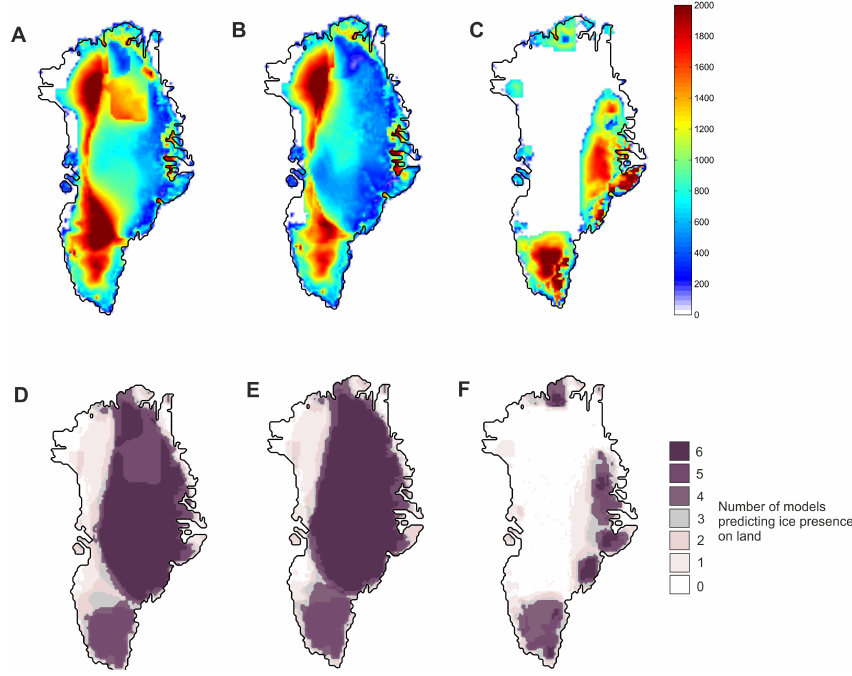
Figure 5. Measures of (a–c) sample standard deviation (SSD) and (d–f) ice sheet presence for scenarios Plio prism . icefree (left panels), Plio prism (middle panels), and Plio nogris . icefree (right panels). See text for